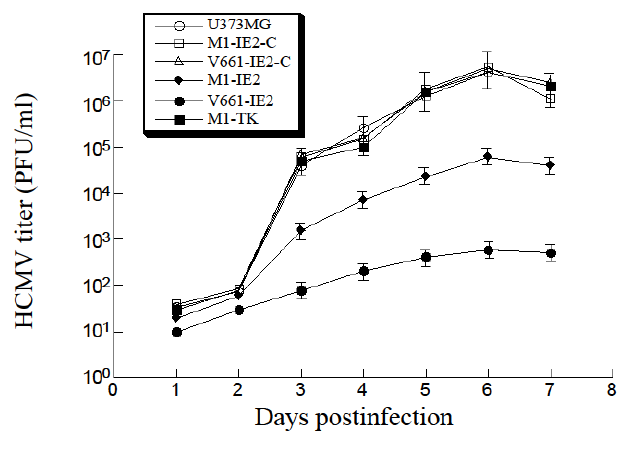
Figure 5. HCMV growth in various cell lines expressing M1GS and the parental U373MG cells. These values are the average from three experiments with error bars showing the standard deviation. p <